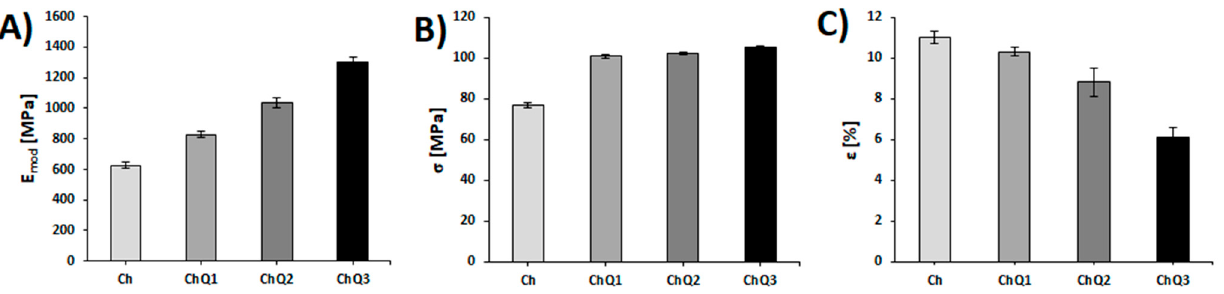
Figure 9. ( A ) Young’s modulus (E mod ); ( B ) tensile strength ( σ ), and ( C ) percentage elongation ( ε ) of chitosan and chitosan with squaric acid 1, 2, and 3 wt.% addition.